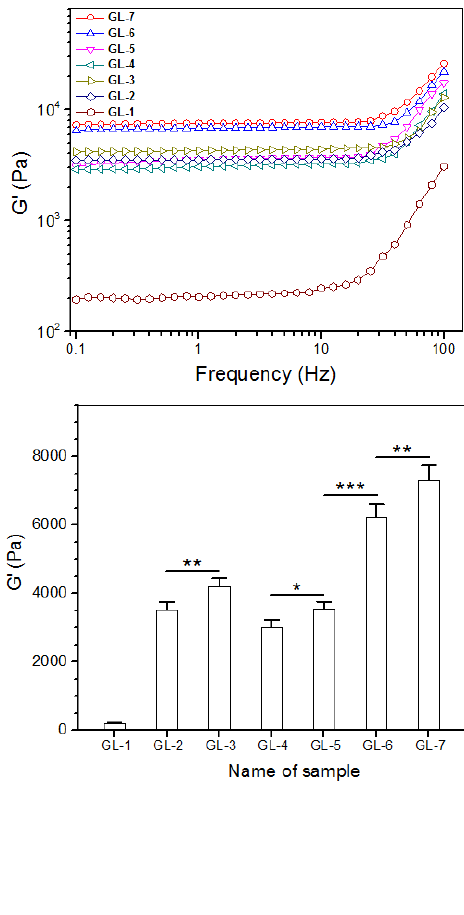
Figure 2. Representative temperature-dependence functions of G ′ and G ′′ for GL-1 ( A ), GL-3 ( B ), GL-5 ( C ) and GL-7 gels ( D ); and incipient gelation temperature (T i ) for all gels ( E ) (see Table 2 for their parameters), N.S., not significant. The gels in Table 2 were further measured for their viscosity variation against shear rates at 25 °C to evaluate their injectability, and the obtained data are plotted in Figure 3. GL-1 had very low viscosity over the shear-rate measurement range. GL- i ( i =2, 3, 4, 5, 6